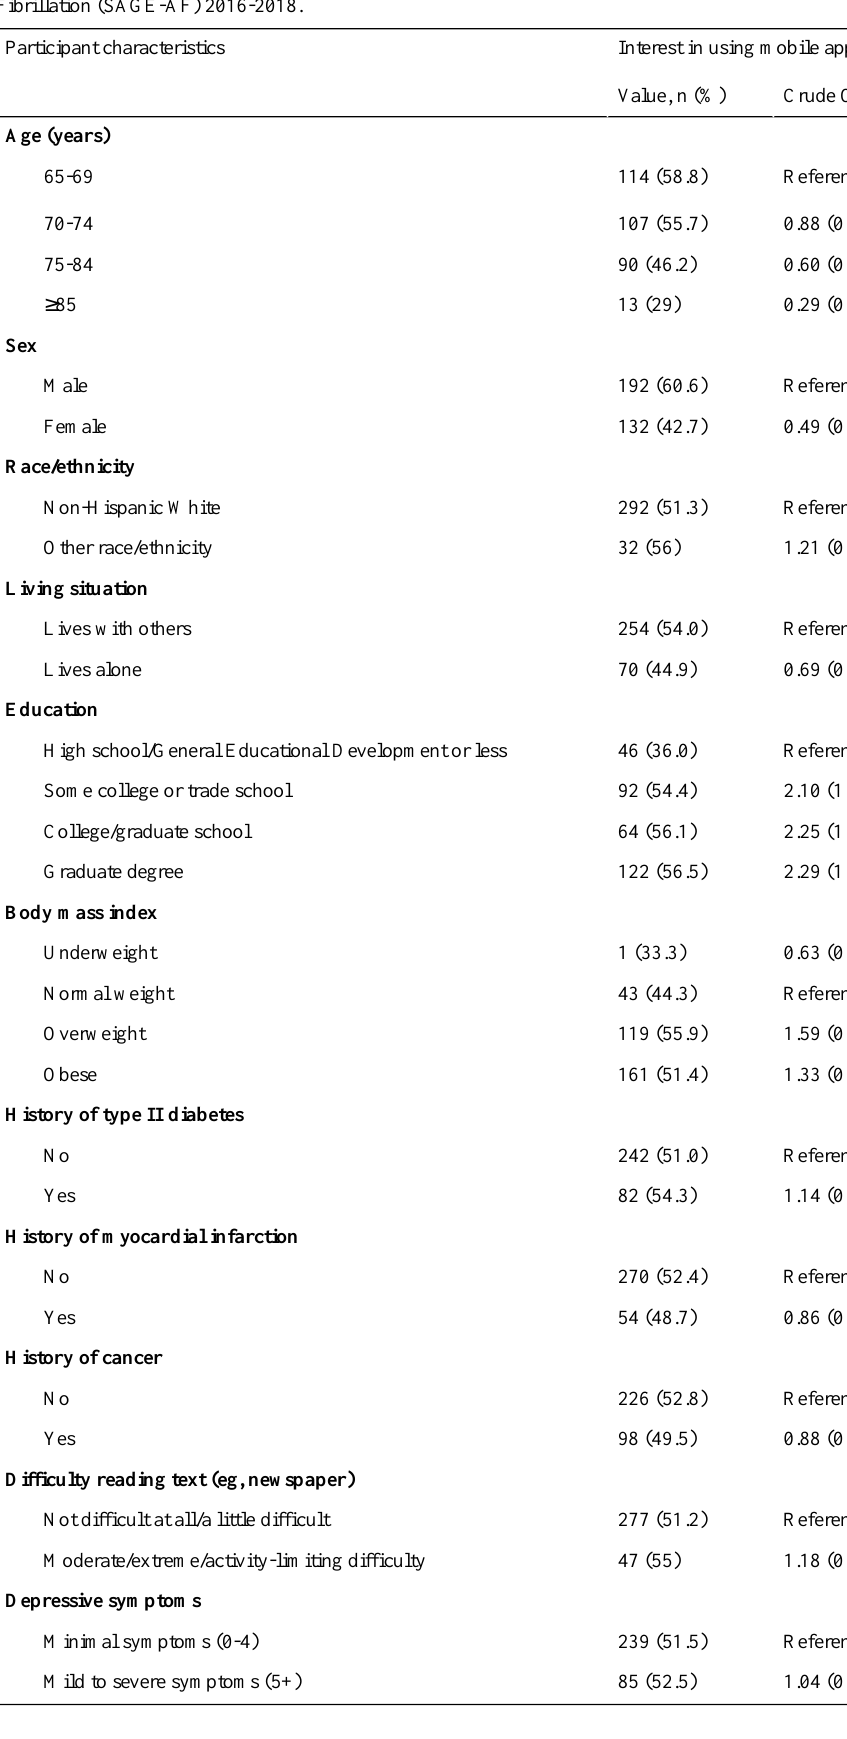
Table 4. Interest in using mobile app to communicate with health care team in relation to demographic, clinical, psychosocial, and technology use characteristics of online older adults with atrial fibrillation who owned mobile devices (n=626), Systematic Assessment of Geriatric Elements in Atrial Fibrillation (SAGE-AF)